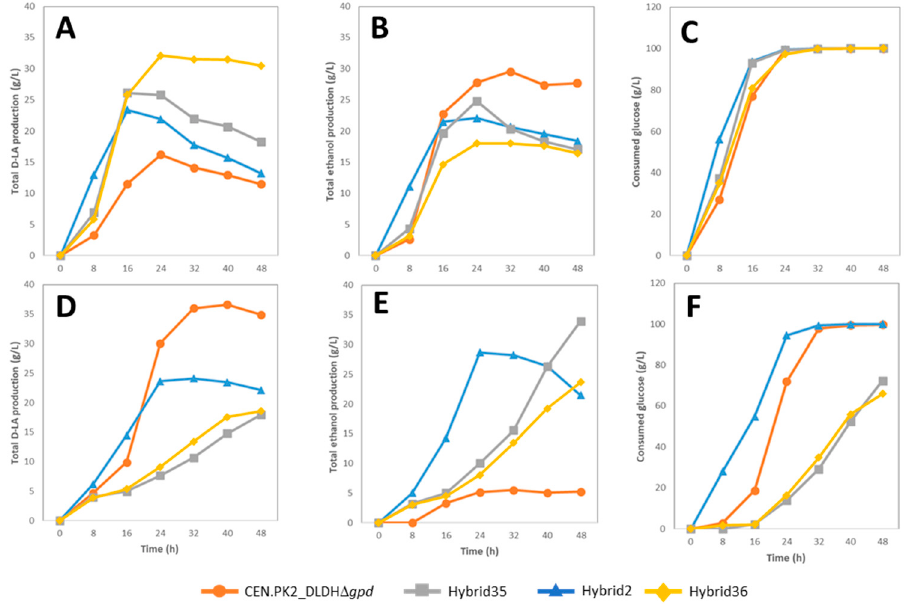
Figure 4. Time courses of glucose conversion to D-lactic acid and ethanol under aerobic conditions. D-lactic acid production in YPD medium containing 100 g/L glucose without synthetic hydrolysate toxins ( A ); ethanol production ( B ) and consumed glucose ( C ). D-lactic acid production in YPD medium containing 100 g/L glucose with synthetic hydrolysate toxins (0.36 g/L formic acid, 1.65 g/L acetic acid, 0.025 g/L levulinic acid, 0.05 g/L vanillin, and 0.018 g/L syringaldehyde) ( D ); ethanol production ( E ) and consumed glucose ( F ). Data represent mean values of biological triplicates and error bars indicate standard deviations.